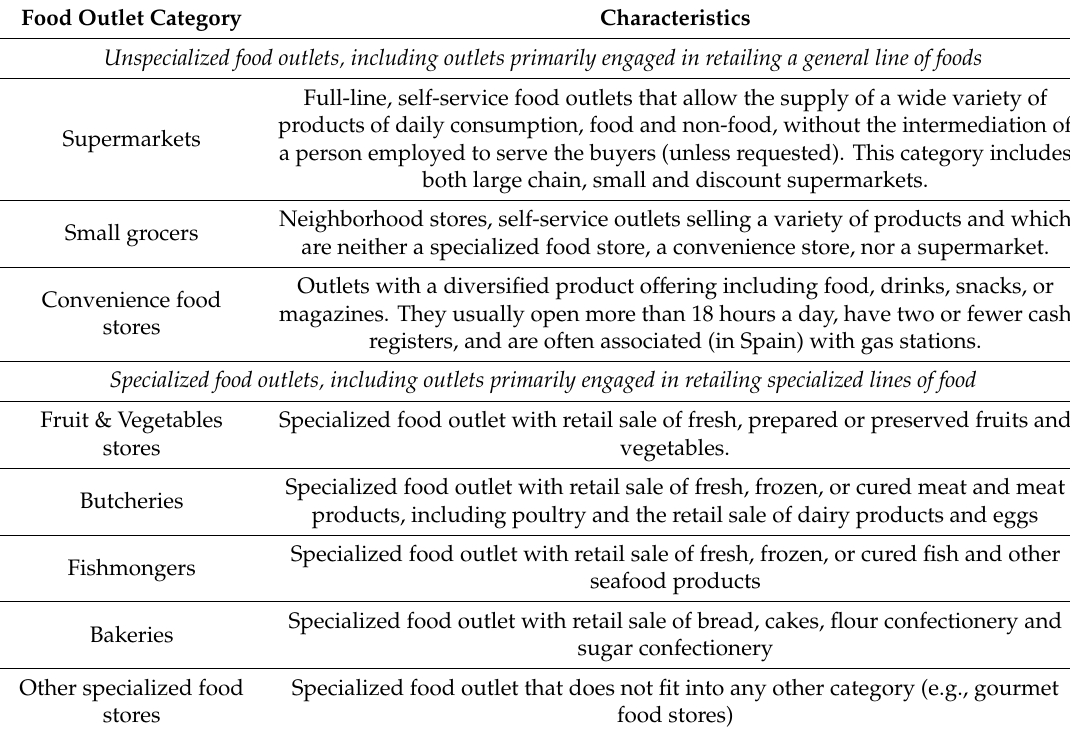
Table 1. Classification of food